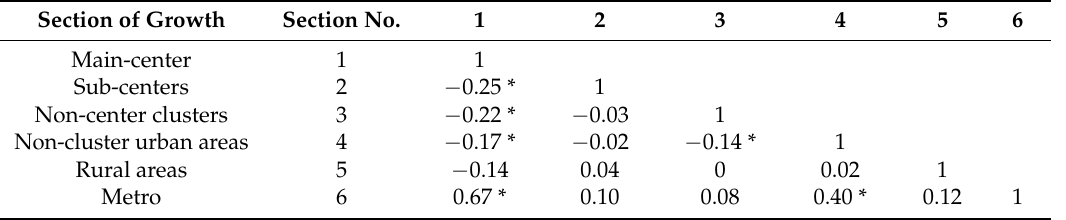
Table 2. Correlation matrix for growth in five submetro sections for small metros. Section of Growth